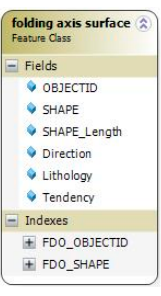
Figure 9. Feature field design of a fold axis.